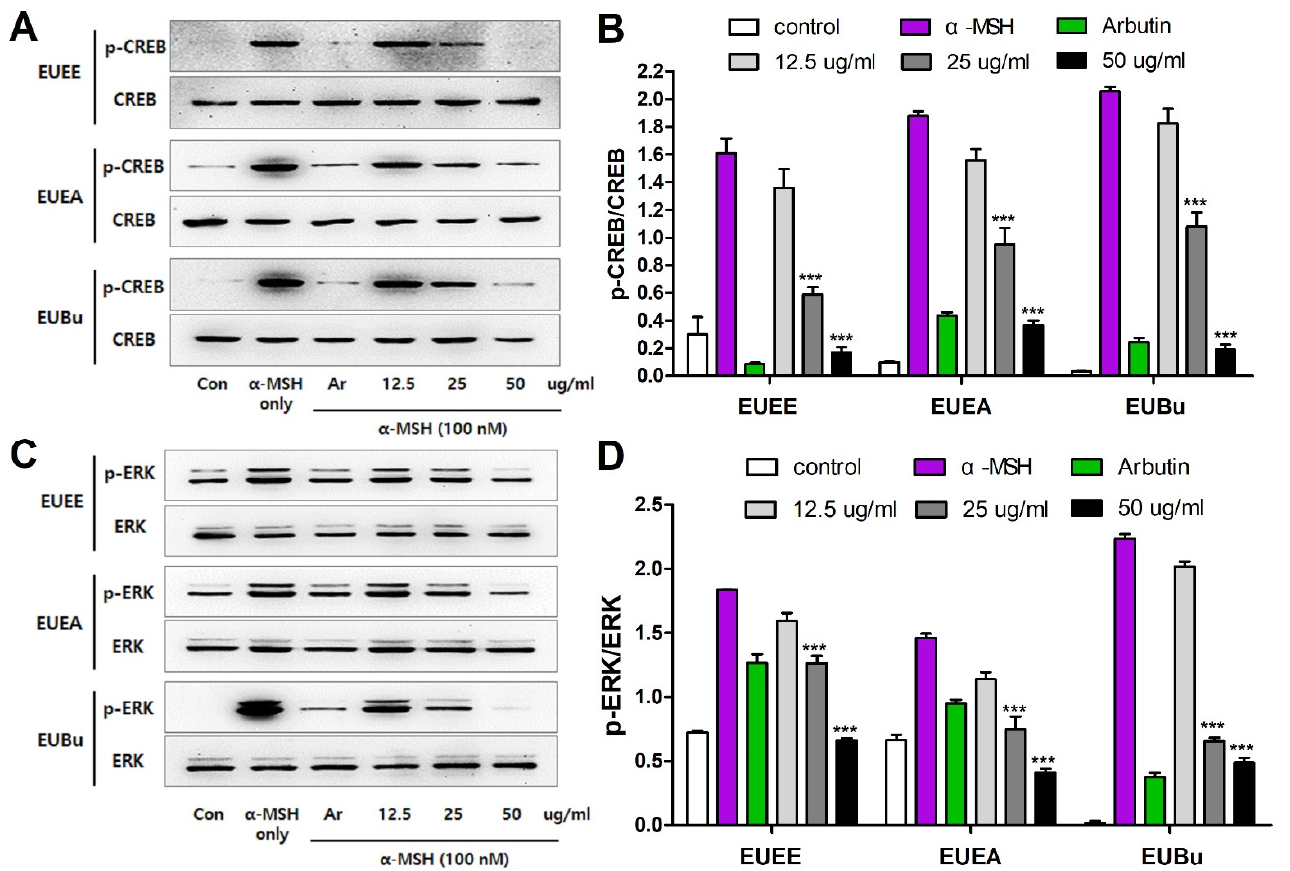
Figure 5. Inhibitory effect of EU on melanogenesis-related CREB and ERK protein expression. Representative western blotting band image of p-CREB and CREB ( A ) and p-ERK and ERK ( C ). Using the GelQuantNET program, the relative intensity of the western blotting band is shown in the following bar graphs: p-CREB/CREB ( B ) and p-ERK/ERK ( D ). Data are expressed as the mean ± S.E.M. (n = 3). Statistical significance was set at *** p < 0.001 when compared with the α -MSH-stimulated B16-F10 cells.